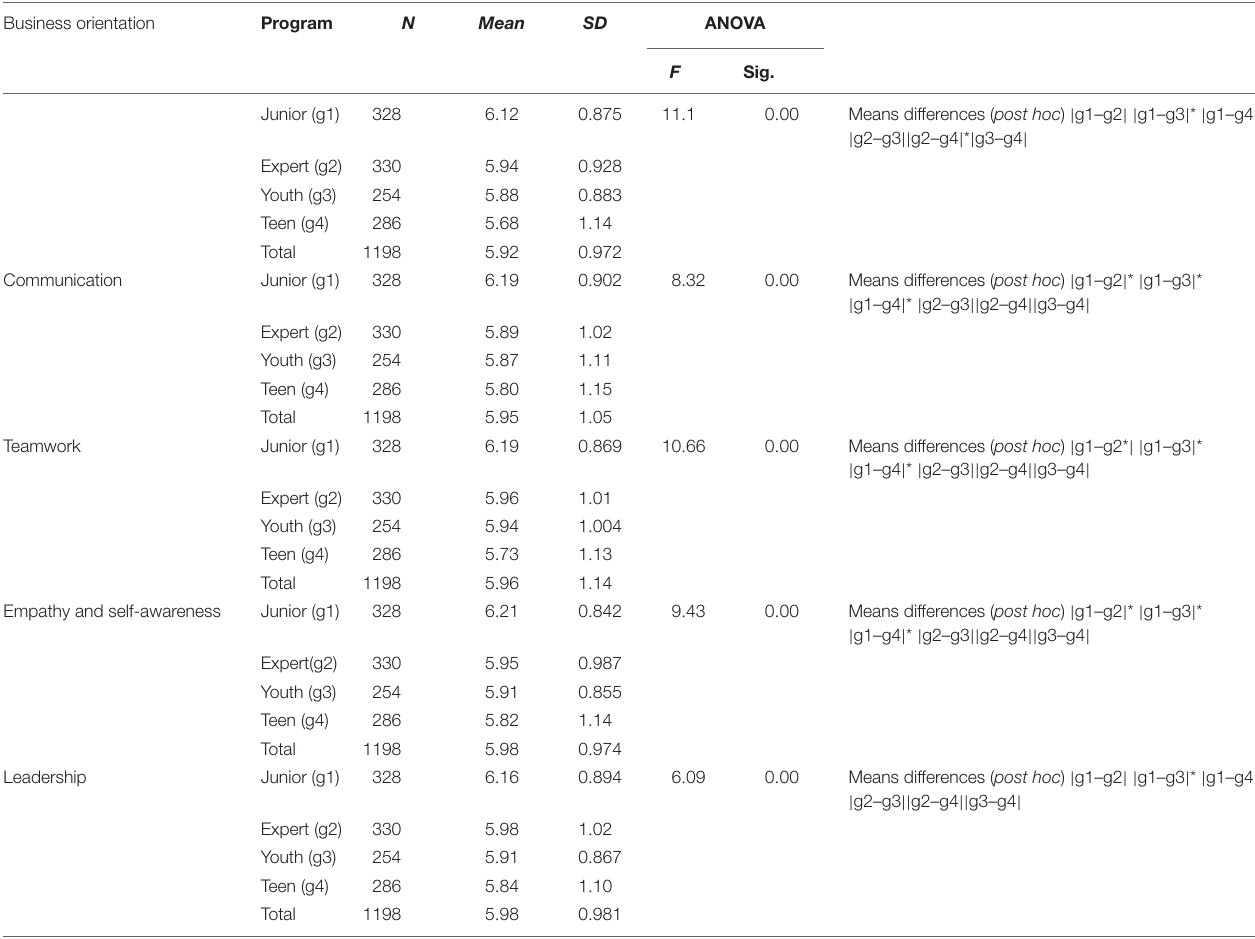
*Significant means difference at 0.05